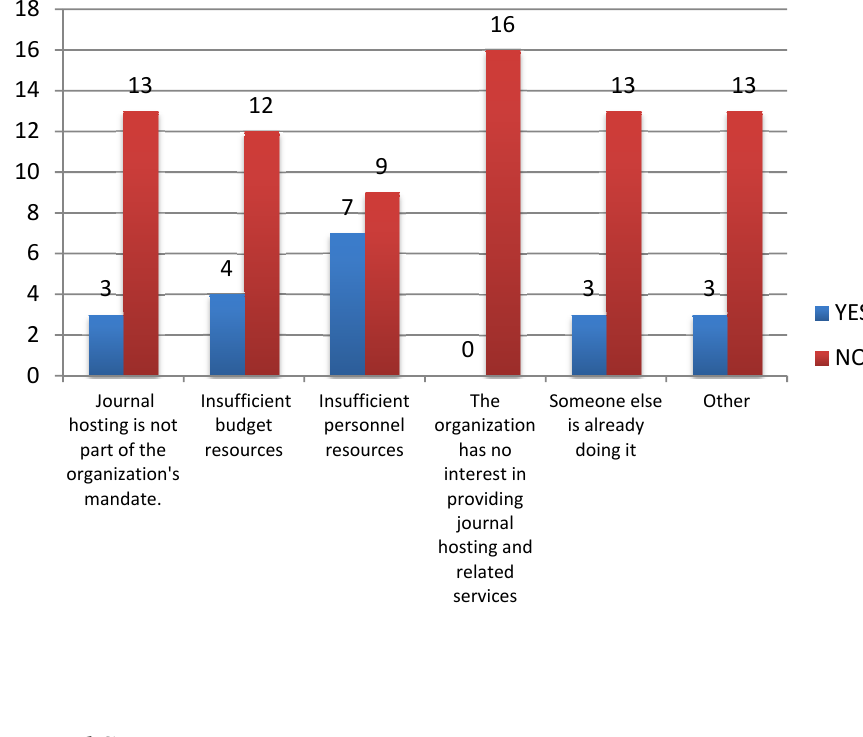
Figure 5. Main reasons for not offering journal hosting